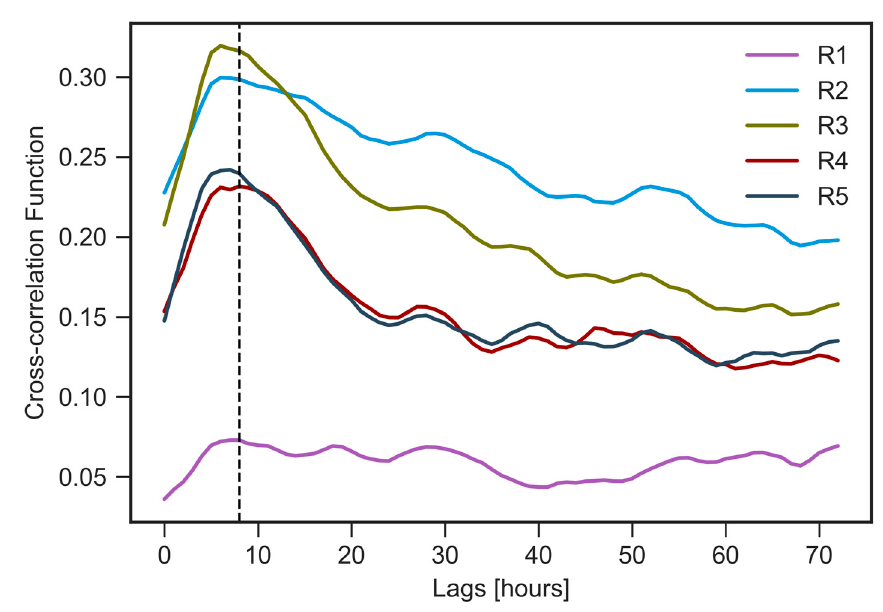
Figure 4. Pearson cross-correlation comparison between the different precipitation time series (derived from the rainfall regions R1-R5 representing the virtual rain gauge stations) and the Matadero-Sayausí discharge station. The dashed line denotes lag 8.